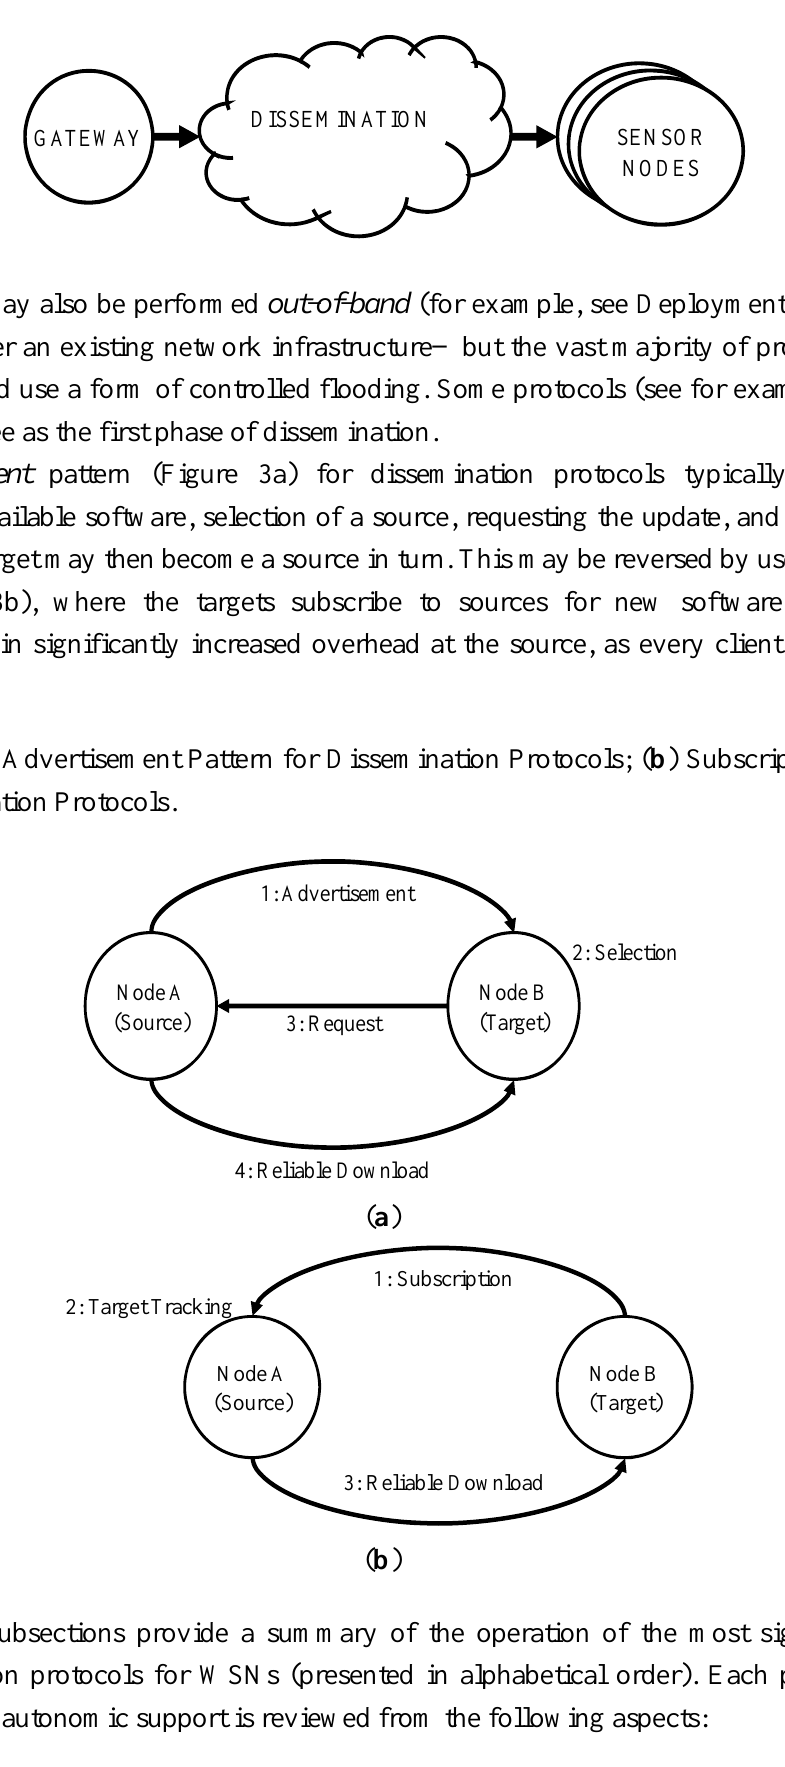
Figure 2. Update Dissemination.